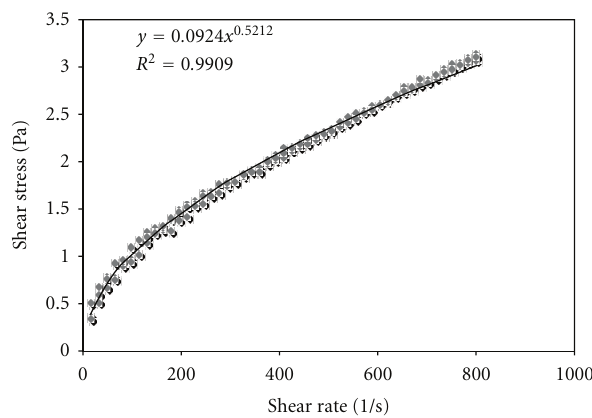
Figure 1: Shear stress dependency on shear rate of 1000ppm Xanthan gum measured by rotational